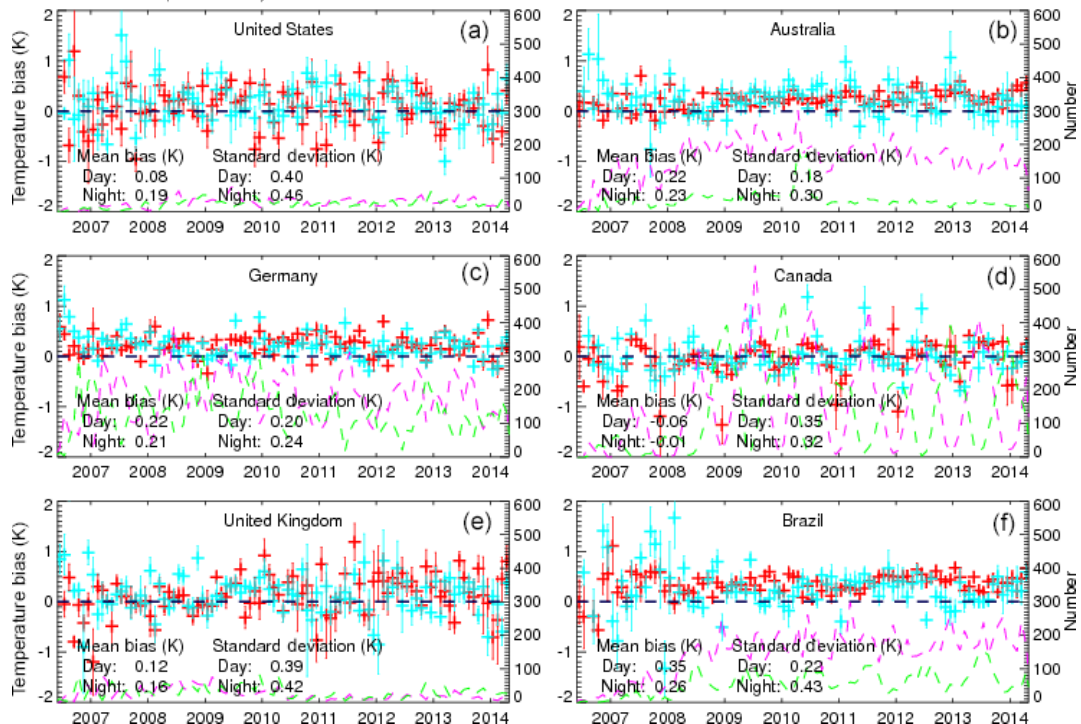
Figure 10. The time series of monthly mean temperature differences from RO at 50hPa for RS92 for (a) United States, (b) Australia, (c) Germany, (d) Canada, (e) United Kingdom, and (f) Brazil. The red cross is the mean difference for RS92 minus RO temperature at 50hPa during the daytime and the blue cross is for that during the nighttime; the vertical lines superimposed on the mean values are the standard error of the mean for daytime and nighttime; the black line indicates zero temperature bias; the pink/green dash line is the sample number for the daytime and nighttime, respectively. The right y axis shows the sample number. The same symbols are also used for the following plots.